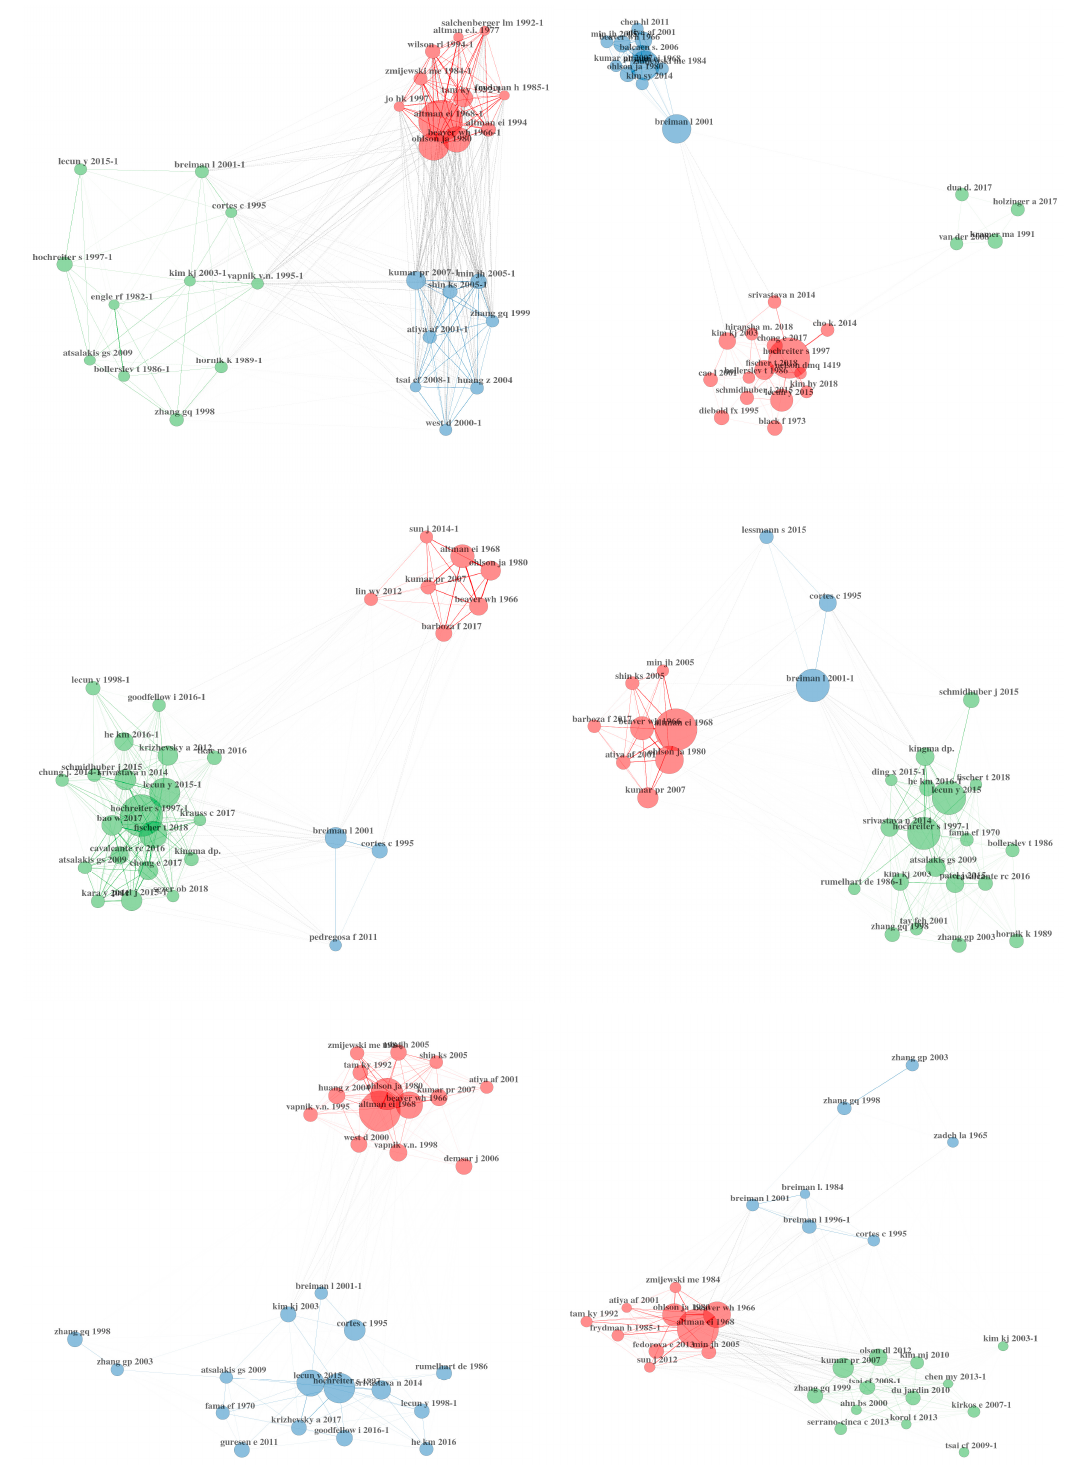
Figure 11. Co-citations of articles, overall period, and per year.